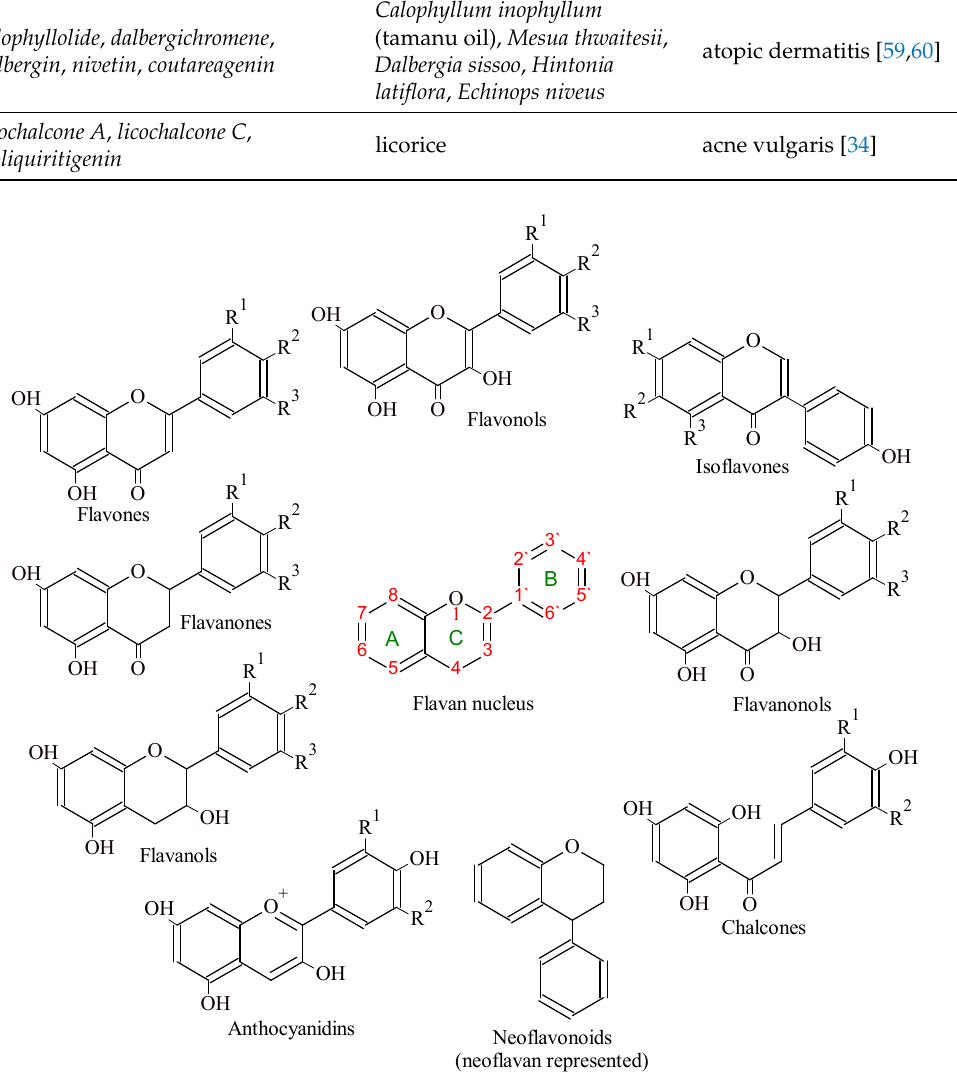
Figure 2. Chemical structure of the basic fl avonoid skeleton and derived groups of fl avonoids.